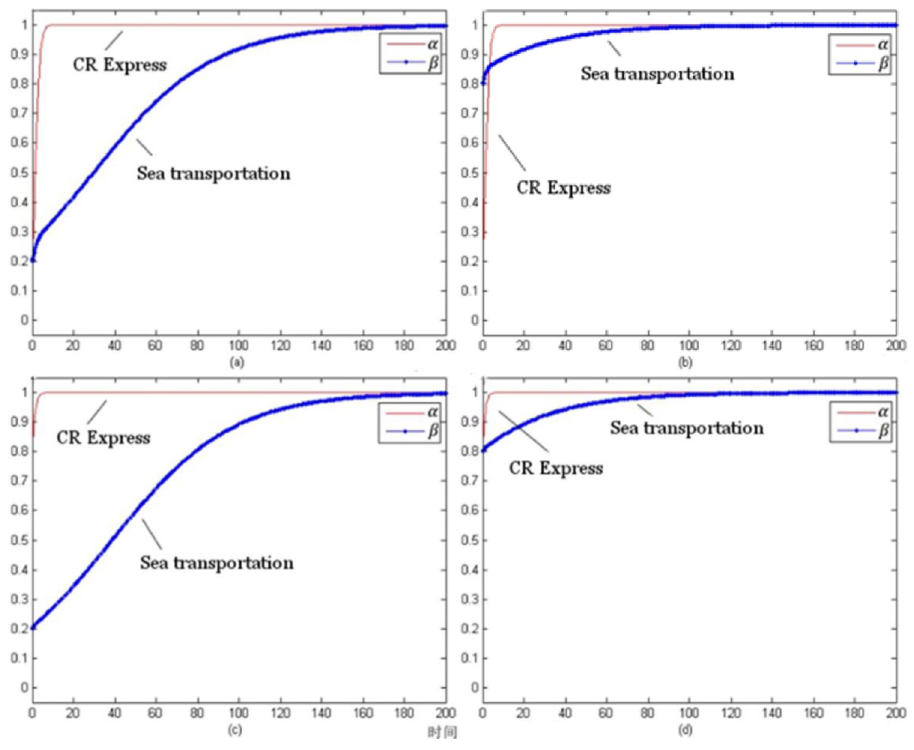
Fig 7. Evolution trend of laptop transportation competition game (without